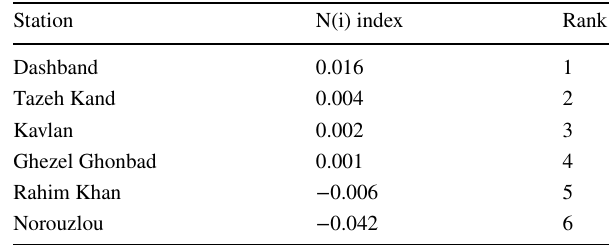
Fig. 6 The violin plot of the variations between the simulated and observed values of the total annual rainfall of the investigated stations accord- ing to the 6-variable Vine simulation method Table 5 Estimates of the RMSE and NSE statistics in simulating the total annual rainfall of the investigated stations